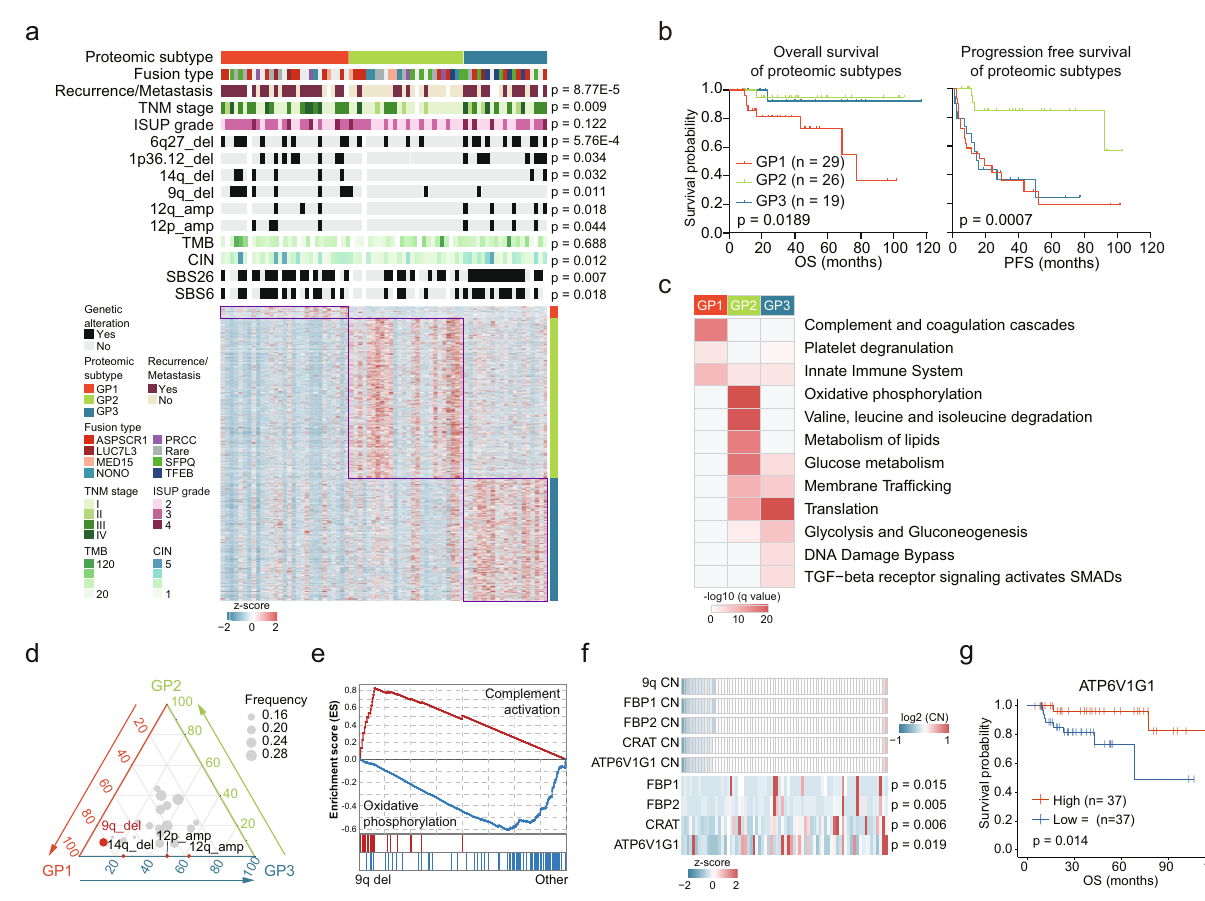
Fig. 6| ProteomicsubtypesoftRCCandassociationswithgeneticfeaturesand clinical outcomes. a Relative abundances of upregulated proteins in the three proteomic subtypes and associations of proteomic subtypes with clinical and genetic features (Fisher ’ s exacttest or Kruskal – Wallistest). b Kaplan – Meier curves of OS and PFS for the three subtypes (two-sided log-rank test). c Upregulated pathways enriched in the three proteomic subtypes. d Ternary plot showing the